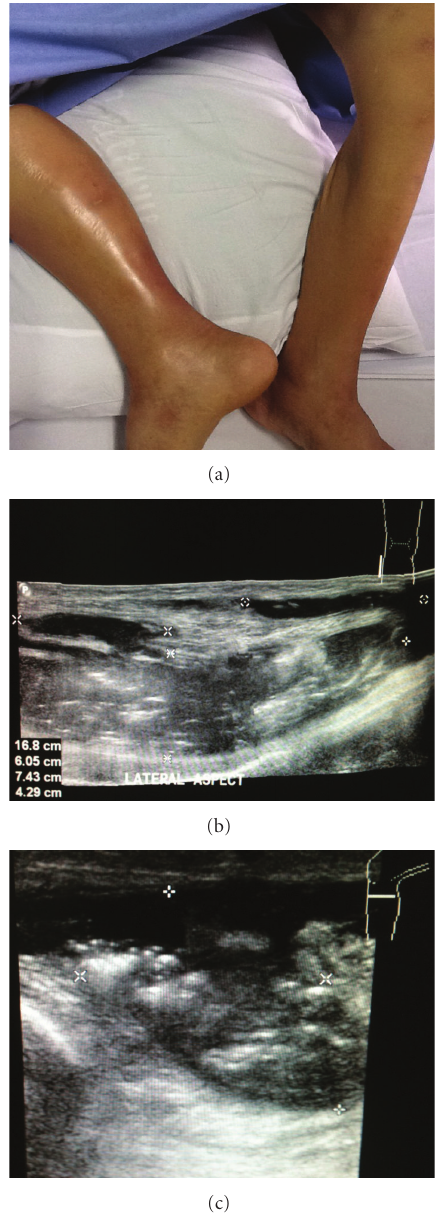
Figure 2: (a) After antimicrobial treatment, there was progressive swelling of right knee extended downward to the calf area, (b, c) ultrasonography of right leg discovered large space of air-filled, heterogeneous multiloculated peri- and intramuscular abscesses, sized 5.4 × 8.6 × 17 centimeters in diameter, extended from popliteal area to ankle